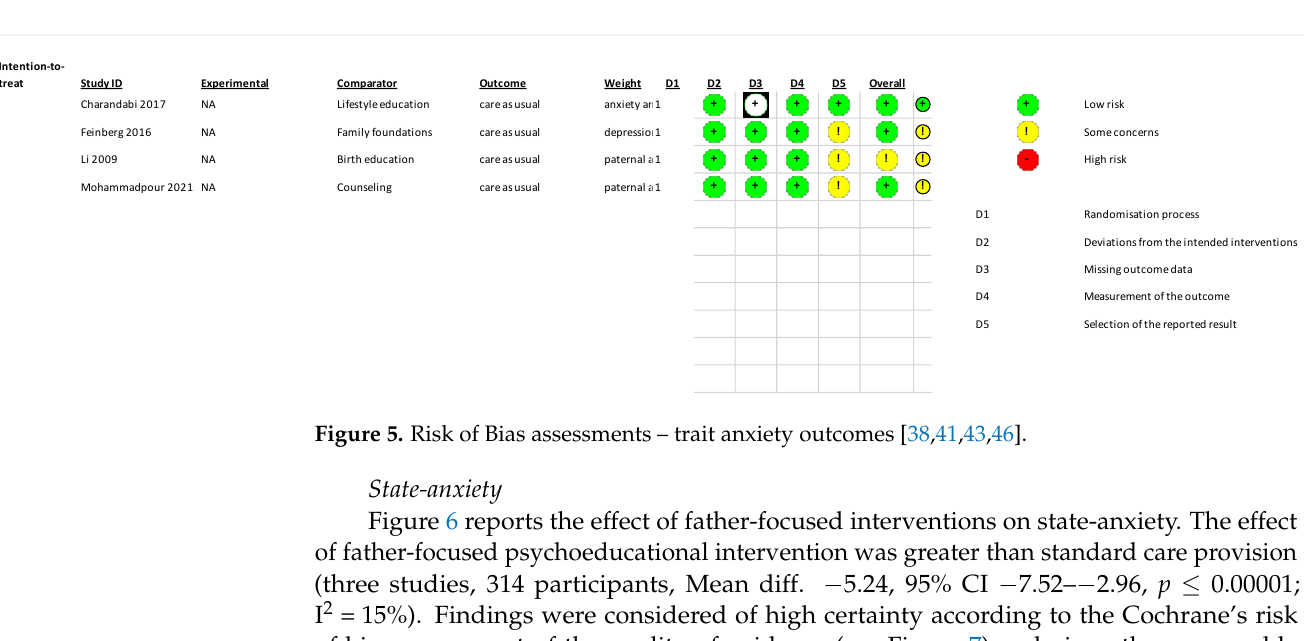
Figure 4. Trait anxiety forest plot [38,41,43,46].